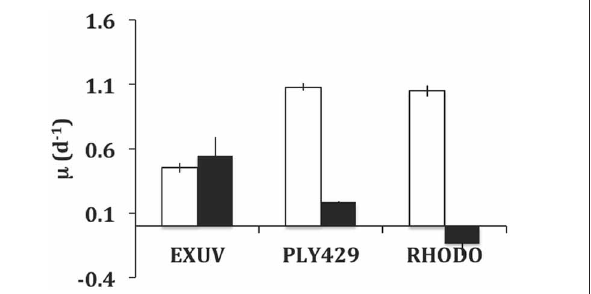
FIGURE 4 | Comparison of growth in light (12:12 cycle) vs. dark (continuous) for Strombidium rassoulzadegani fed one of three microalgae: Prorocentrum minimum (EXUV), Tetraselmis chui (PLY429), or Rhodomonas lens (RHODO). Error bars are ranges of duplicates.